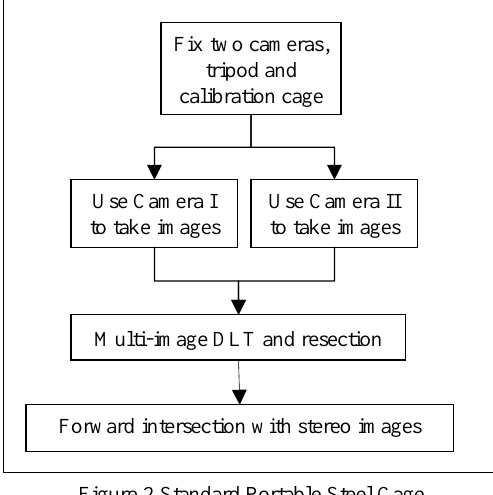
Figure 2 Standard Portable Steel Cage